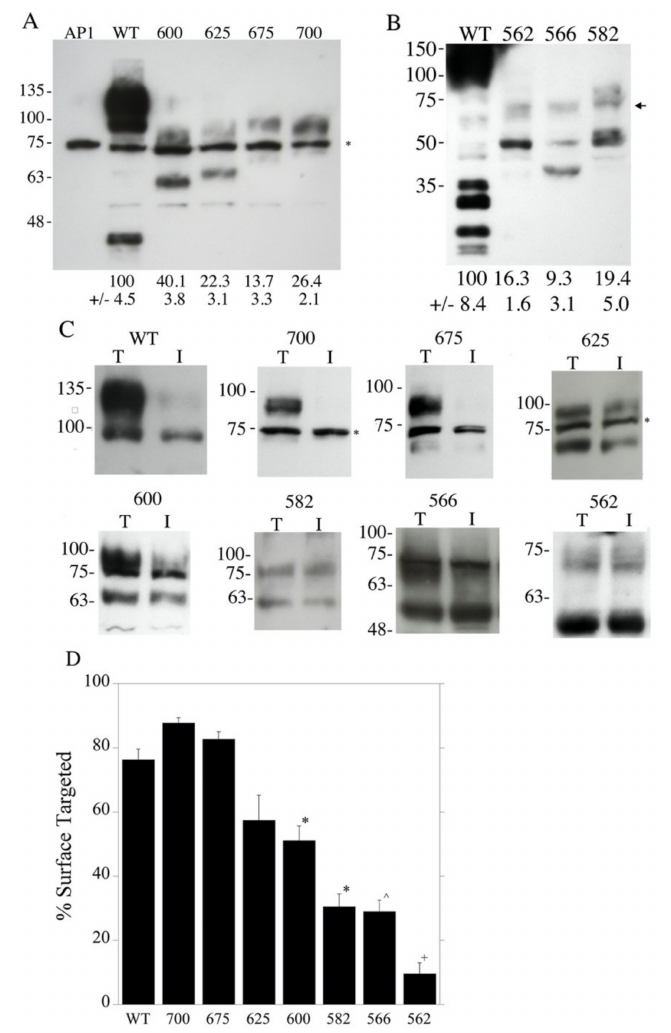
Figure 2. Expression and targeting of wild type NHE1 and mutants NHE-562, NHE-566, NHE-582, NHE-600, NHE-625, NHE-675 and NHE-700. ( A ) Western blot of whole cell lysates of stably transfected AP1 cells containing the indicated plasmids NHE-600, NHE-625, NHE-675 and NHE-700. Asterisk indicates a non-specific immunoreactive band that was present in all cell lysates. WT, wild type. AP1, mock transfected AP1 cells. The level of expression, relative to the wild type, is indicated below each lane. * indicates non-specific immunoreactive protein. ( B ) Analysis of mutant expression as in “A” with mutants NHE-562, NHE-566 and NHE-582. Exposure time was increased to allow for the visualization of the mutant expression. Arrow indicates the approximate position of the shortened NHE1 proteins. ( C ) Surface localization of the wild type (WT) and mutant NHE1 proteins in AP1 cells. The results are mean ± the S.E, n = at least 3 determinations. After external cell surface biotinylation, equal amounts of total cell lysates (T) and unbound intracellular lysates (I) were examined by Western blotting with anti-HA antibody to identify the NHE1 protein. WT and mutant cell lines (NHE-562, NHE-566, NHE-582, NHE-600, NHE-625, NHE-675 and NHE-700 are indicated). Lysates were from cell lines stably expressing wild type NHE1 and mutant NHE1 proteins, respectively. * indicates non-specific immunoreactive protein. ( D ) Summary of surface localization of WT and mutant NHE1 proteins in AP1 cells (as in “C”). * indicates values that were significantly di ff erent from the control values at p < 0.05. ˆ indicates significantly values that were di ff erent from control values at p < 0.01. + indicates significantly di ff erent from NHE-566 at p <